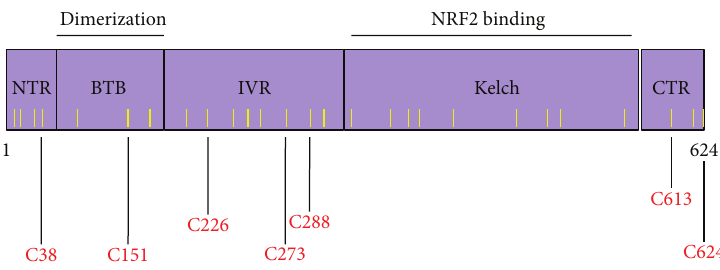
F 2: Domain structure of human KEAP1. NTR: N-terminal region (amino acids